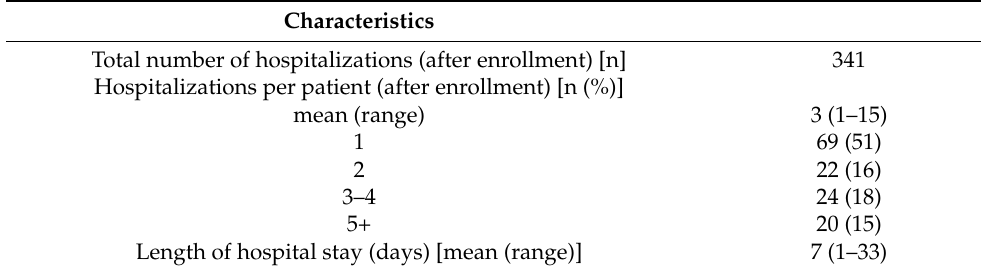
Table 2. Frequency of patient hospitalizations. Includes all n = 135 African American patients with at least one readmission to the hospital during the three-year study